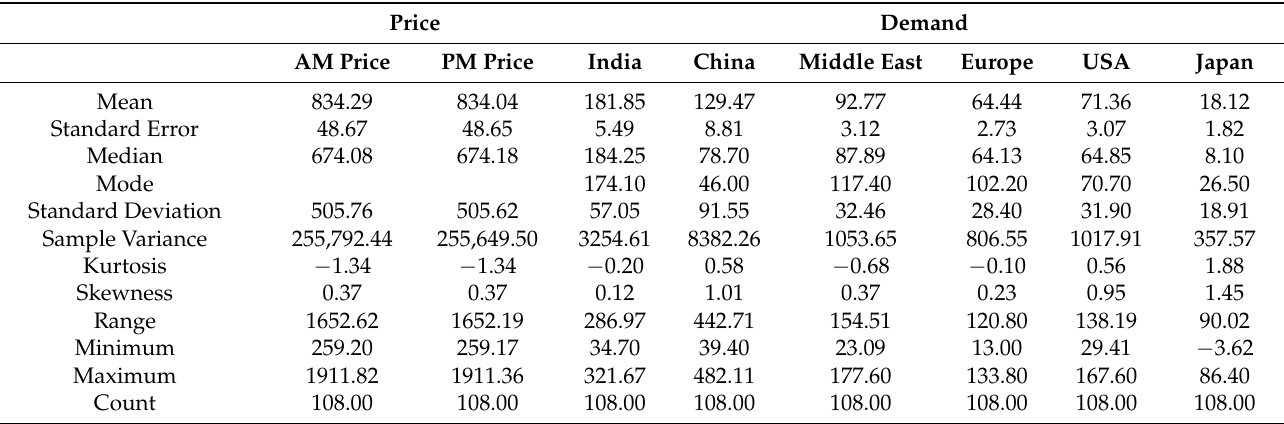
Table 1. Descriptive statistics of the variables.